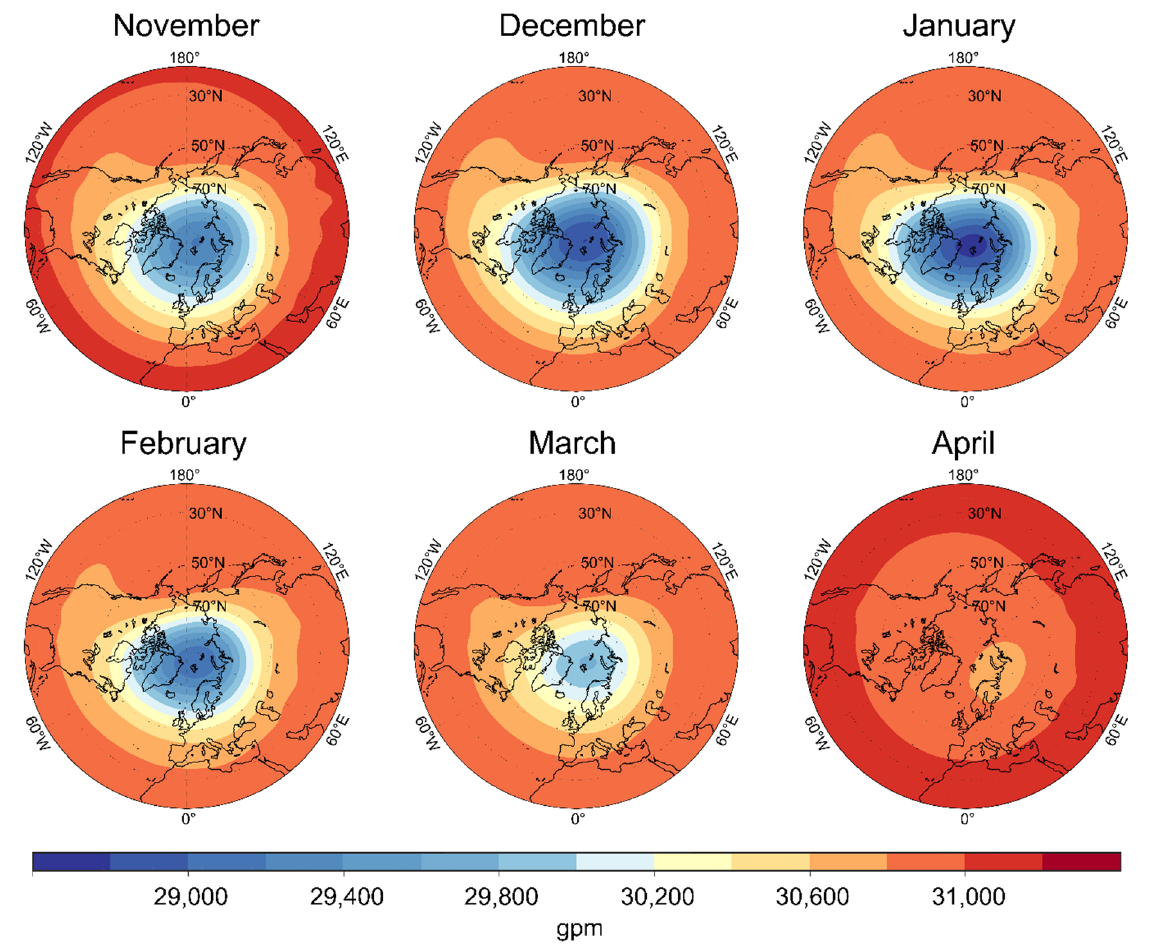
Figure 1. Mean geopotential height at 10 hPa over the period 1950 – 2005 for each month from November to April. Contour interval is 200 gpm. The outermost latitude is 20° N.